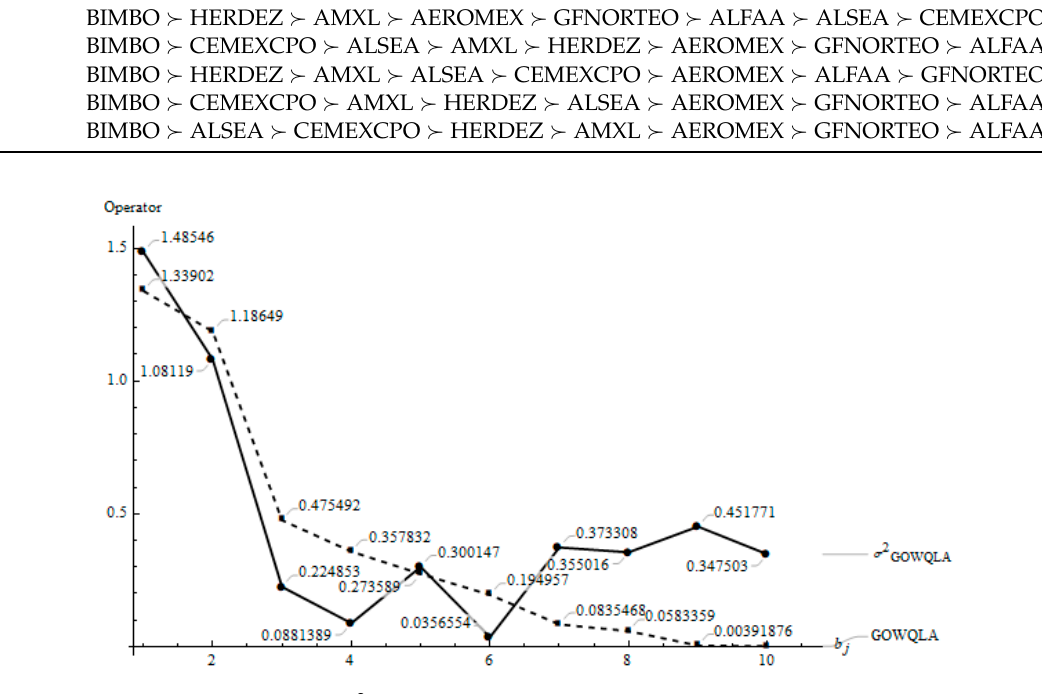
Figure 7. GOWQLA and 𝜎 (cid:2870) (cid:2891)(cid:2899)(cid:2907)(cid:2901)(cid:2896)(cid:2885) operators evaluating CEMEXCPO.